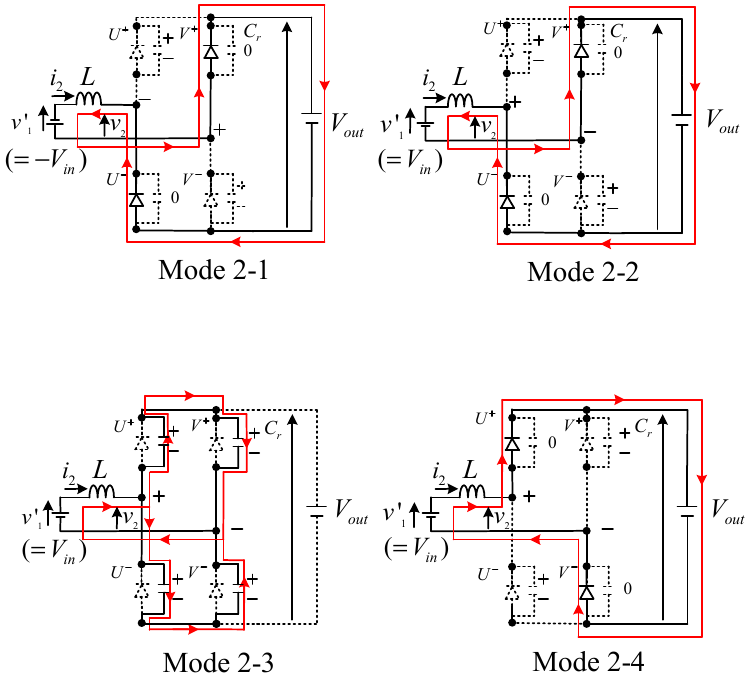
Figure 6. Commutations of the secondary diode rectifier circuit.